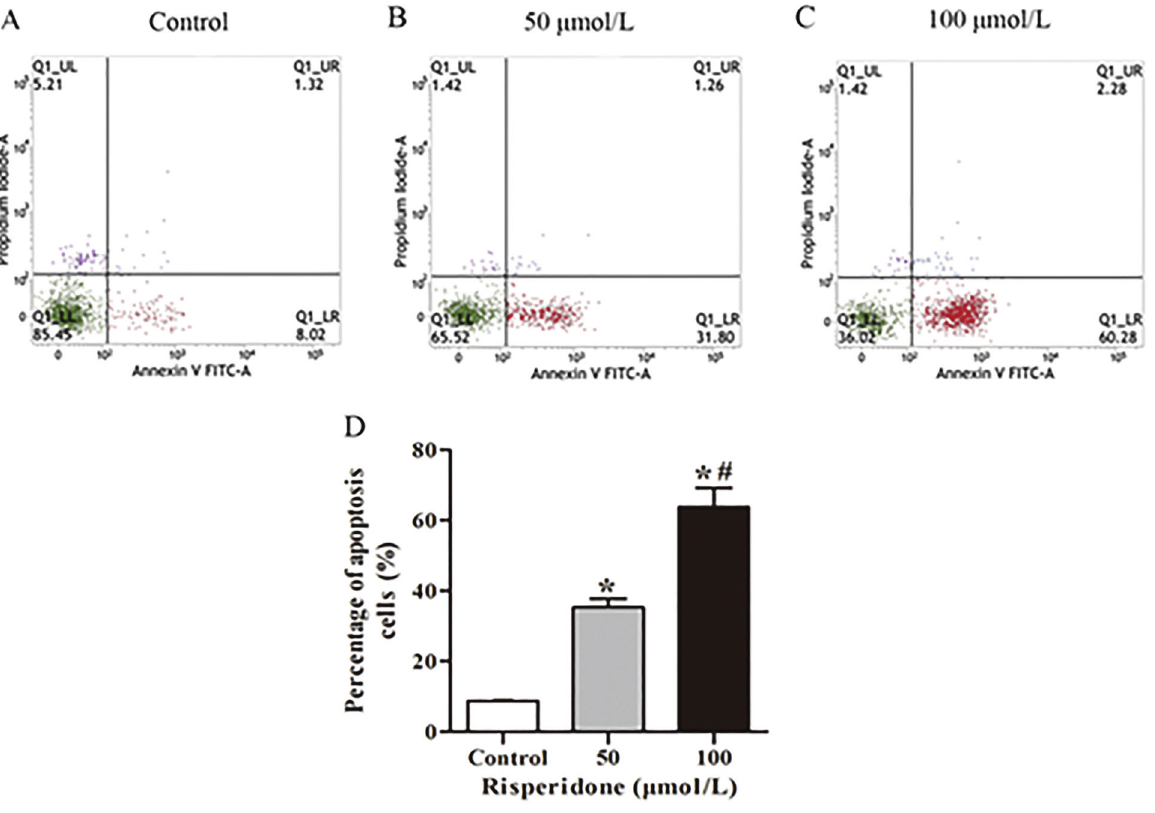
Figure 2. Risperidone reduced MC3T3-E1 cell apoptosis. The images indicate results for control ( A ), 50 m mol/L ( B ), and 100 m mol/L ( C ) risperidone. The graph in ( D ) was generated from three independent experiments. Data are reported as means ± SD. *P o 0.05, comparing 50 m mol/L or 100 m mol/L risperidone-treated groups with the control group. # P o 0.05, comparing 50 m mol/L treated group with 100 m mol/L treated group (one-way